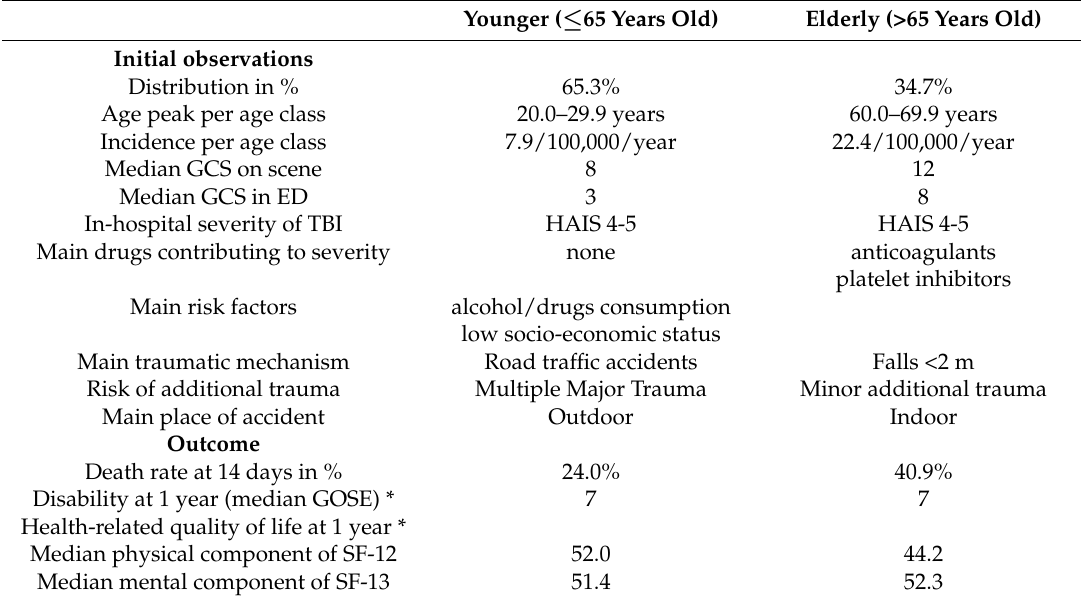
Table 1. Differences related to age after severe traumatic brain injury (TBI) in adult patients based on reference